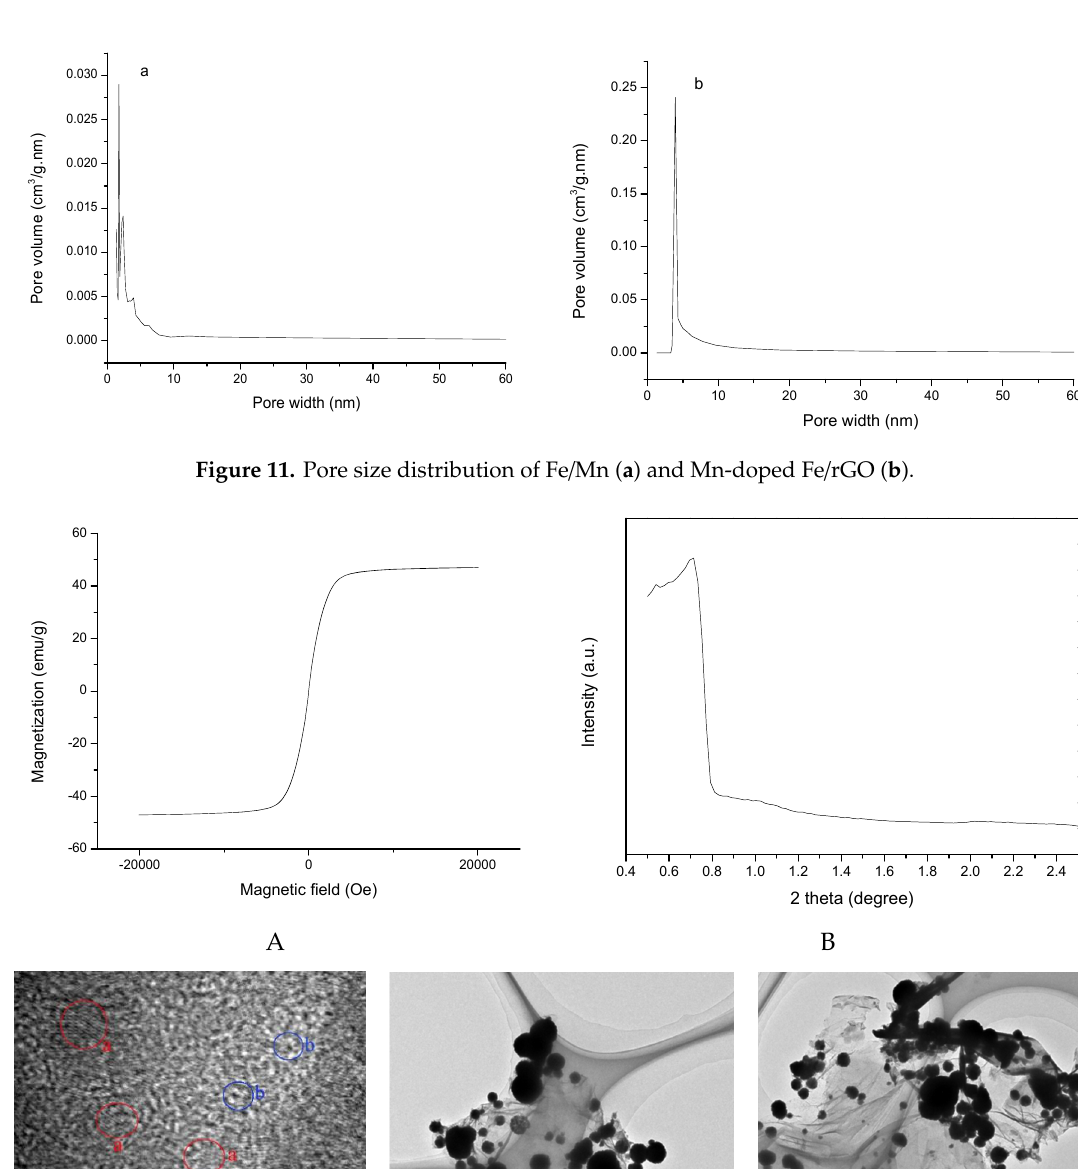
Figure 11. Pore size distribution of Fe/Mn ( a ) and Mn-doped Fe/rGO ( b ).